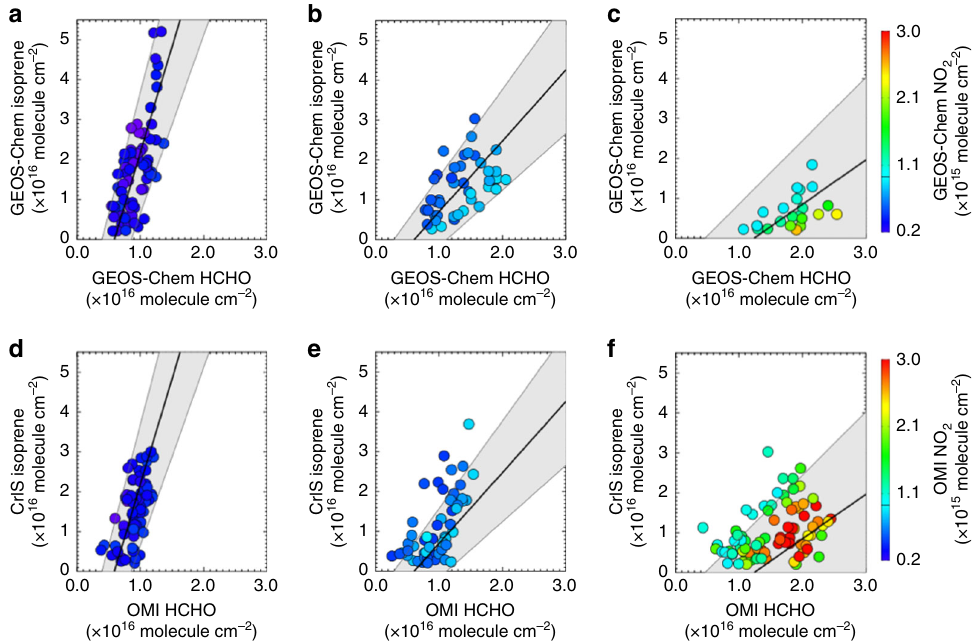
Fig. 9 Relationship between isoprene and HCHO as a function of NO 2 over Amazonia during September 2014. Panels a – c show the isoprene:HCHO column relationship as simulated by GEOS-Chem over land under conditions of a low-NO 2 column abundance (<0.65 × 10 15 moleculecm − 2 ), b moderate NO 2 (0.65 – 1.1 × 10 15 moleculecm − 2 ), and c high NO 2 (>1.1 × 10 15 moleculecm − 2 ). The lines and shaded regions indicate the major axis regression and associated 90% con fi dence interval in each case. Panels d – f show the measured relationships as observed by the CrIS and OMI satellite sensors superimposed on the corresponding modeled regressions